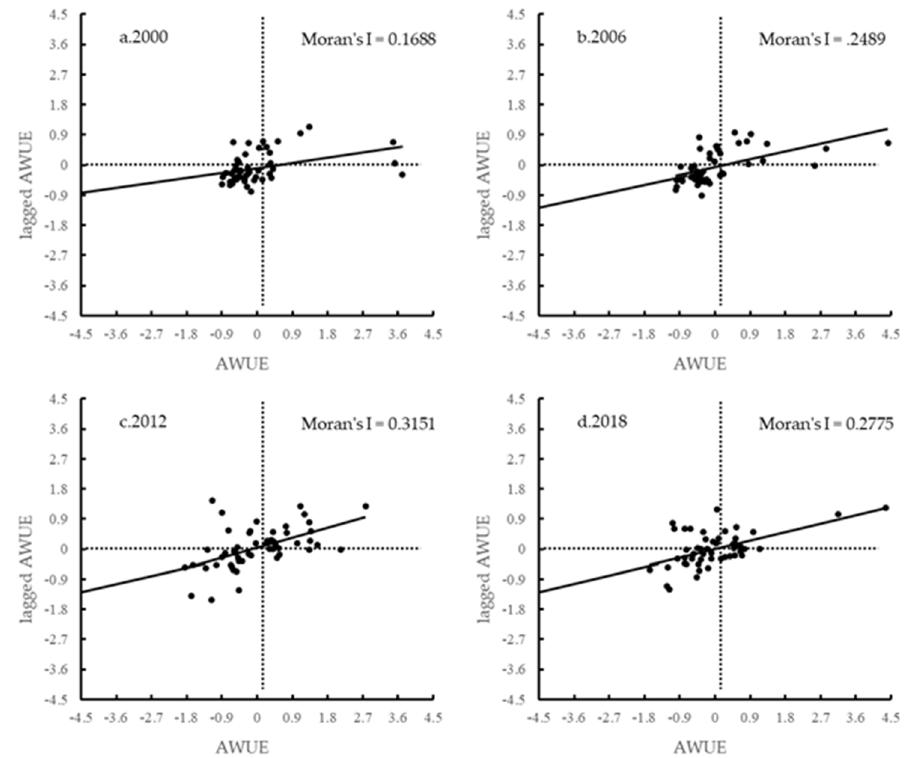
Figure 4. The Moran scatter map of AWUE in Northwest China from 2000 to 2018.